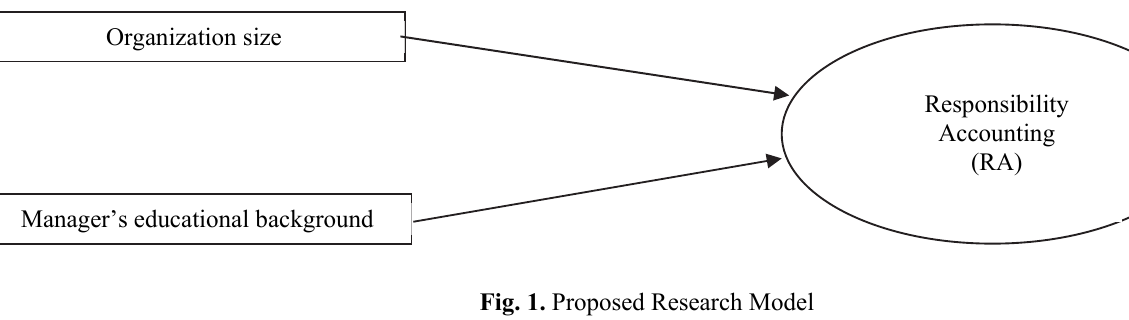
Fig. 1. Proposed Research